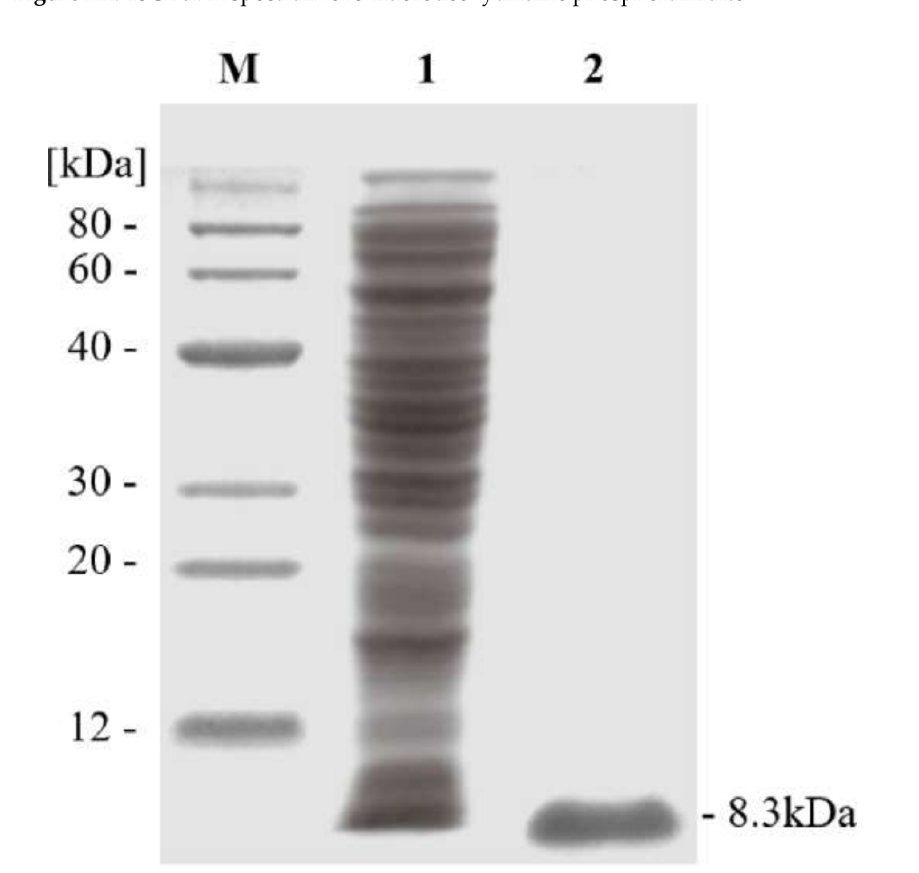
Figure A3. Characterization of purified affibody. The crude lysate of E. coli expression and purified affibody were loaded onto a 12% SDS-PAGE gel with protein weight standards. Lane 1, crude lysate of E. coli expression; Lane 2, purified